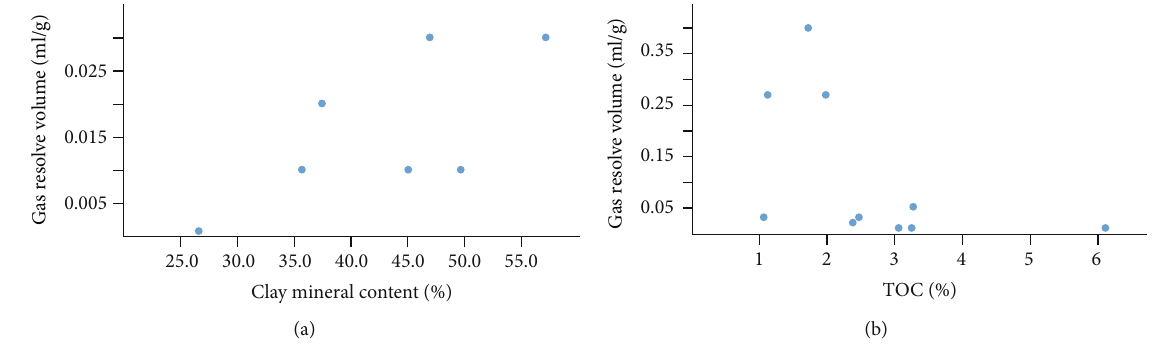
Figure 11: Relationship between fi eld resolved gas and TOC, clay mineral